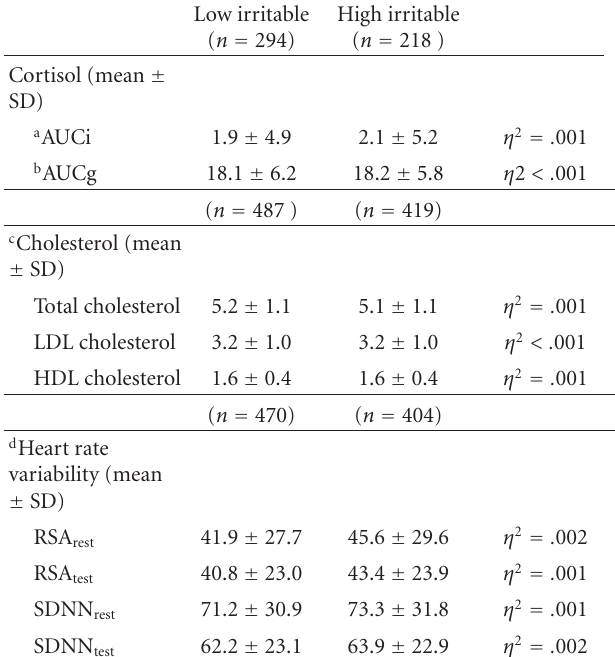
Table 2: Demographic and clinical characteristics of low and high irritable depressed patients—multivariate results a .